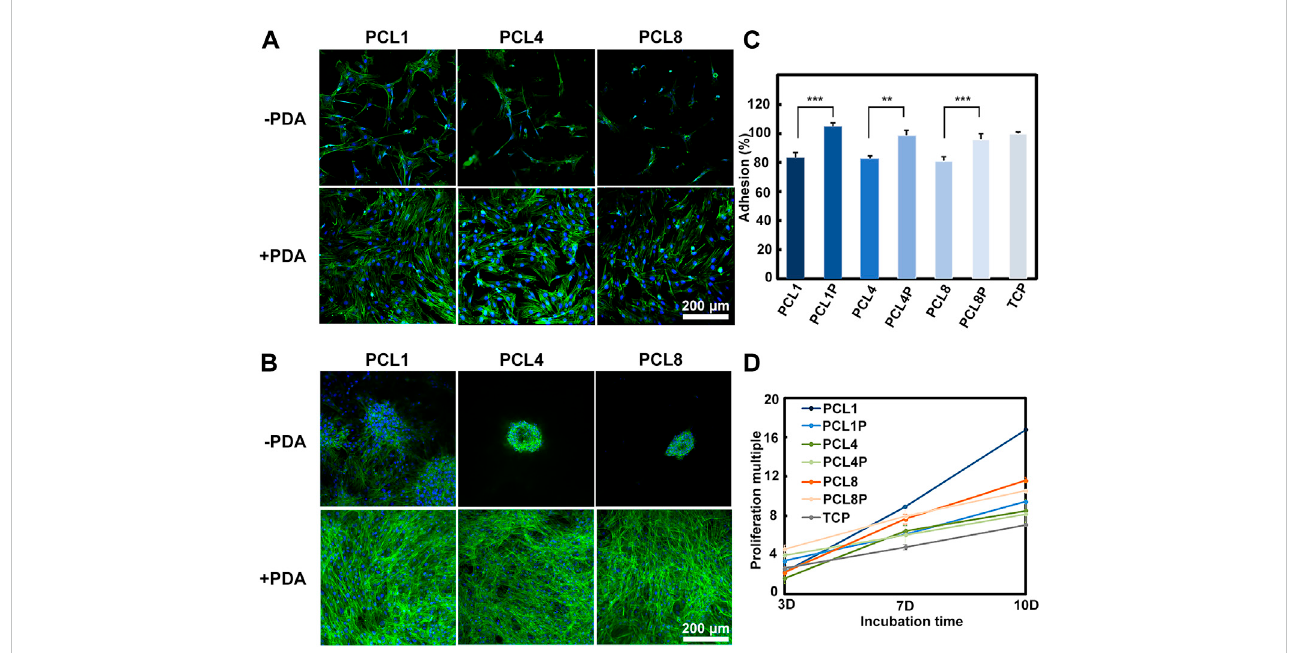
FIGURE 2 Behaviors of BMMSCs cultured on different substrates. (A) The fl uorescent images of BMMSCs cultured on different substrates for 1 day and (B) 7 days (green:Actin;blue:Nuclear)( n =3). (C) CCK-8assayofBMMSCsculturedonsamplesfor1 day( n =4). (D) TheproliferationofMSCsondifferentsubstratesfor up to 10 days ( n =